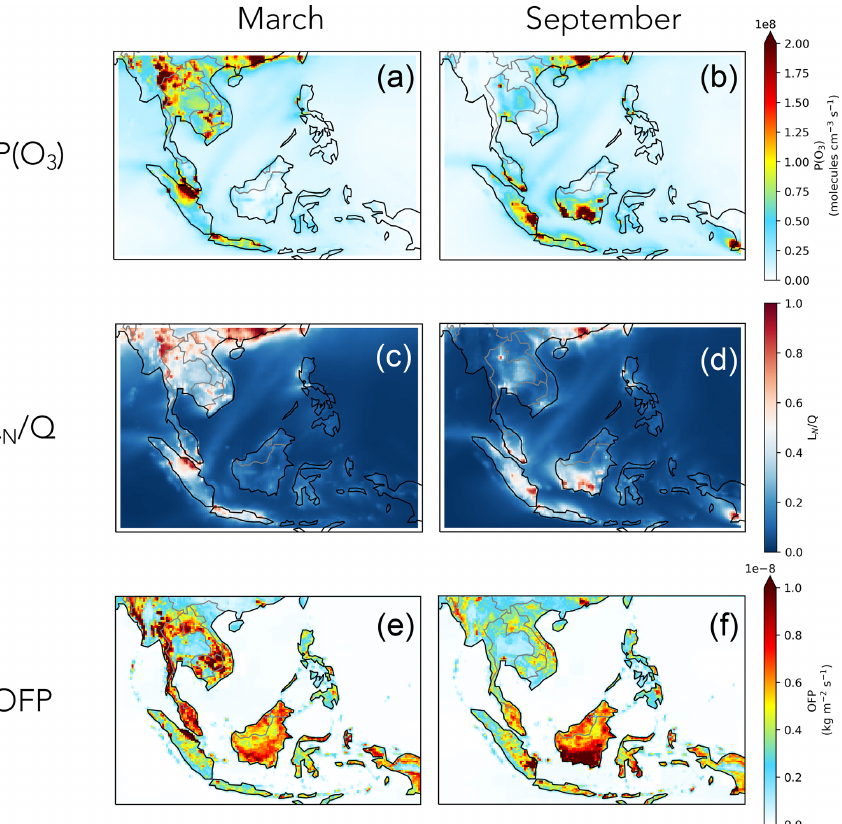
Figure 8. Spatial distribution of model ozone sensitivity indicators across Southeast Asia in March and September 2014. (a, b) Mean ozone production rate (molec.cm − 3 s − 1 ) in the PBL during the daytime (06:00–18:00). (c, d) Mean L N /Q in the PBL during the daytime (06:00– 18:00). (e, f) Ozone formation potential (kgm − 2 s − 1